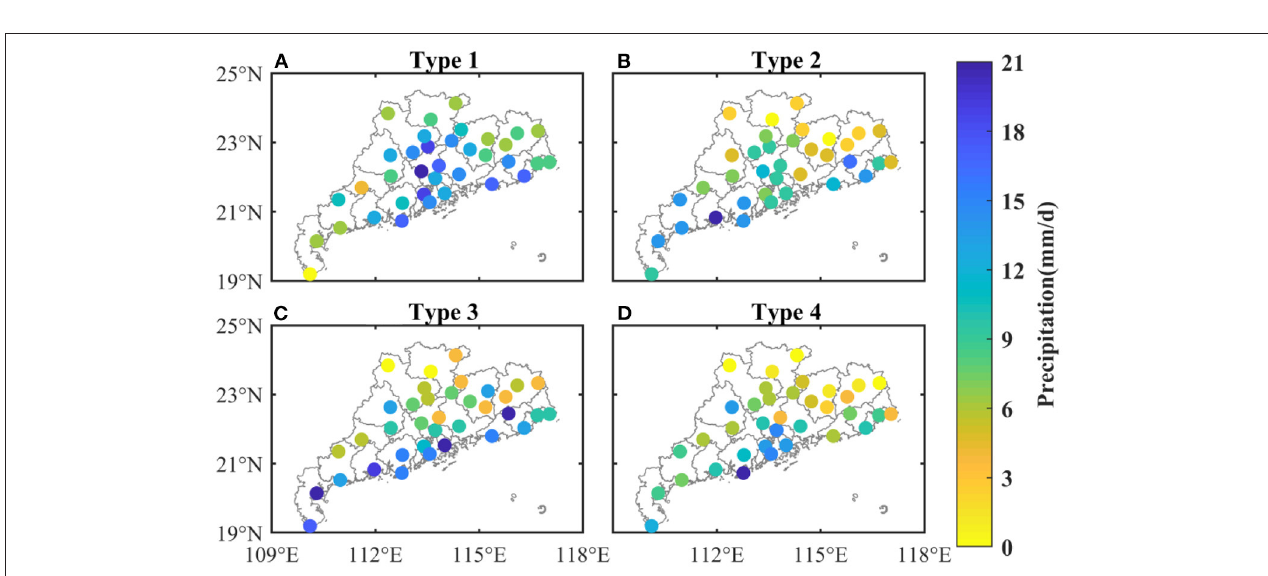
FIGURE 4 | Spatial distribution of daily summer precipitation under four weather patterns: (A) Type 1, (B) Type 2, (C) Type 3, and (D) Type 4.